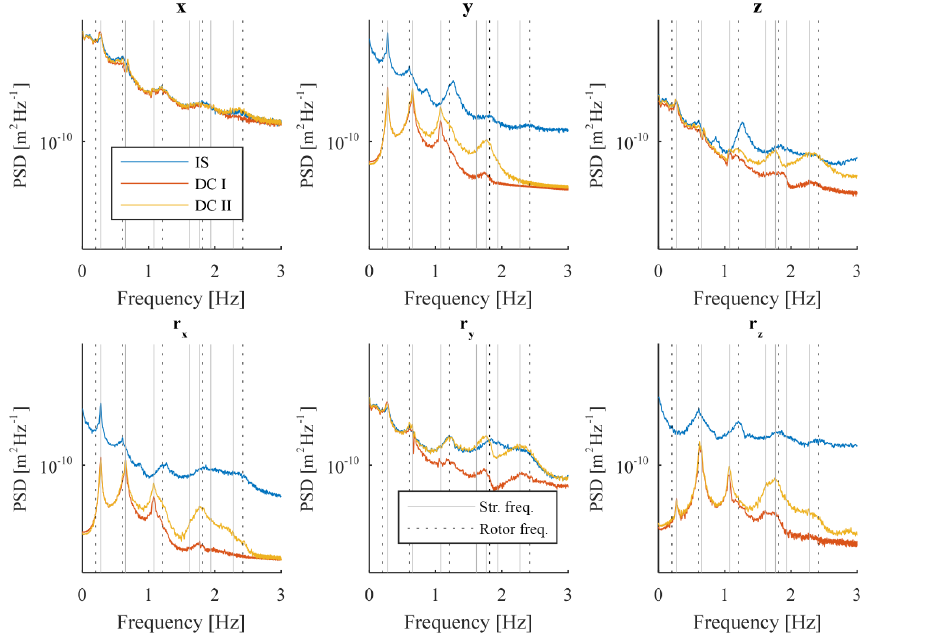
Figure 9. PSD for tower top displacements of DC I and DC II with a wind speed of 20ms − 1 .